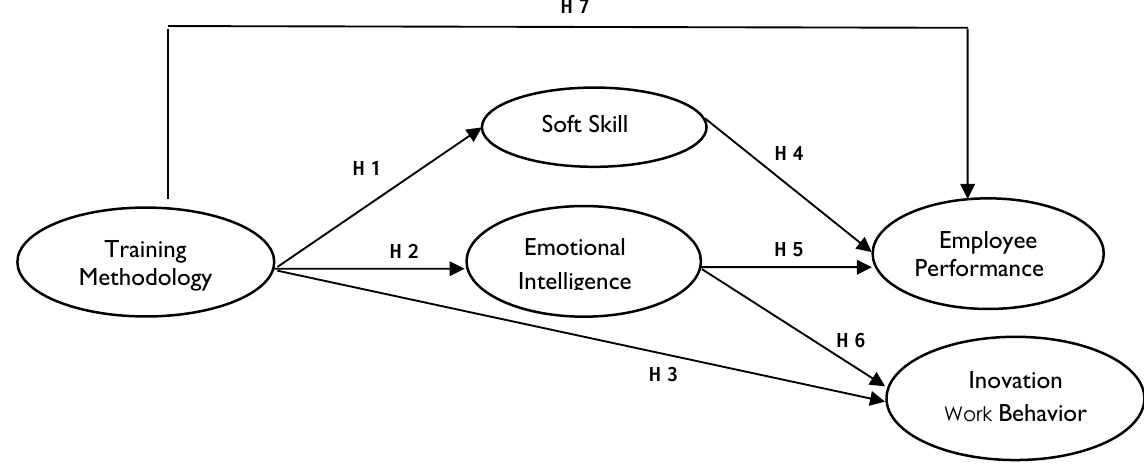
Figure 1 . Research Model